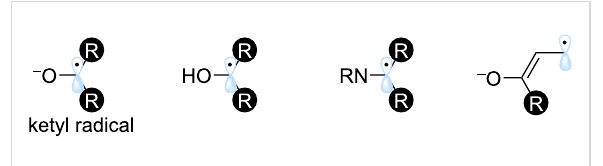
Figure 3: Structure of C–X radical anions and their neutral derivatives.